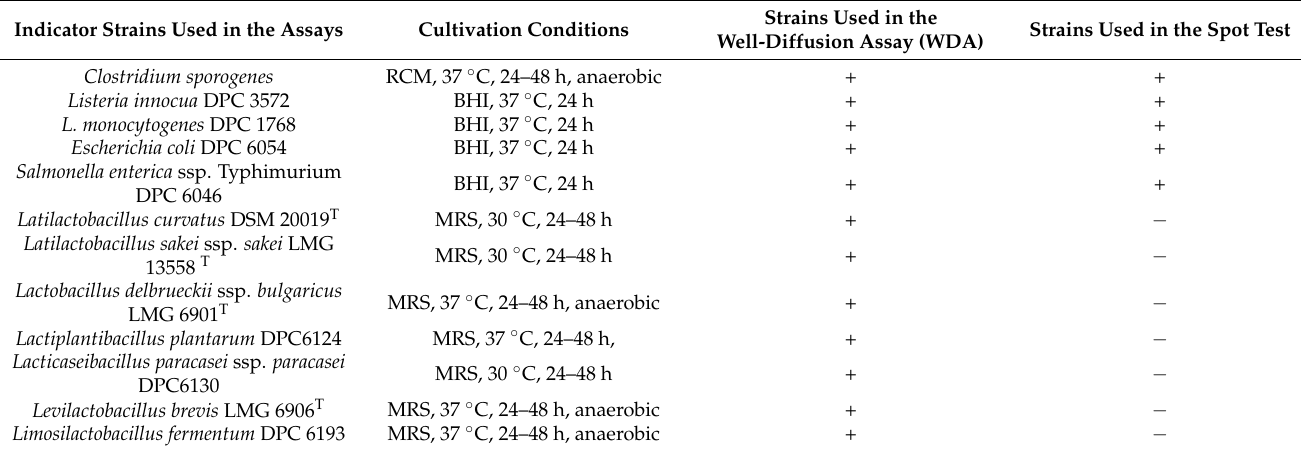
Table 2. Indicator strains used for the in vitro antimicrobial